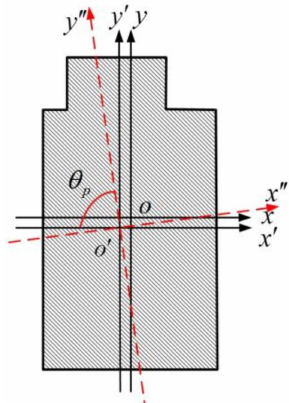
Figure 3. Cross-sectional view of the oblique beam in the Sensonor Company’s gyroscope.